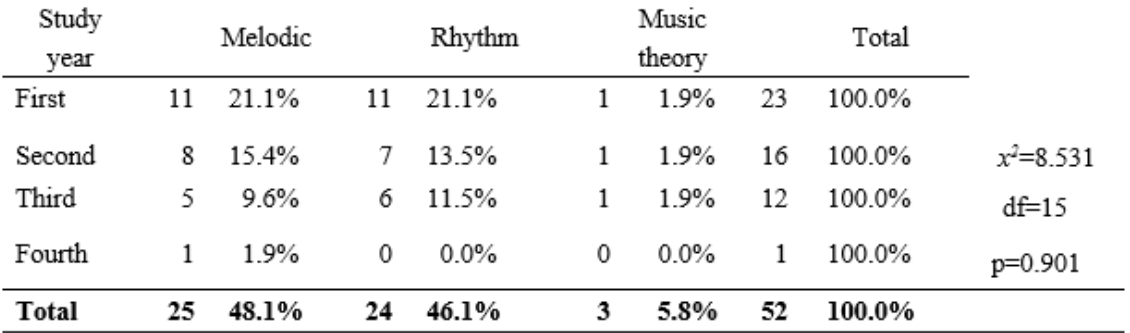
Table 7. Student's attitudes about which area of solfeggio contributes the most to the ad - vancement of instrumental performance in relation to the year of study